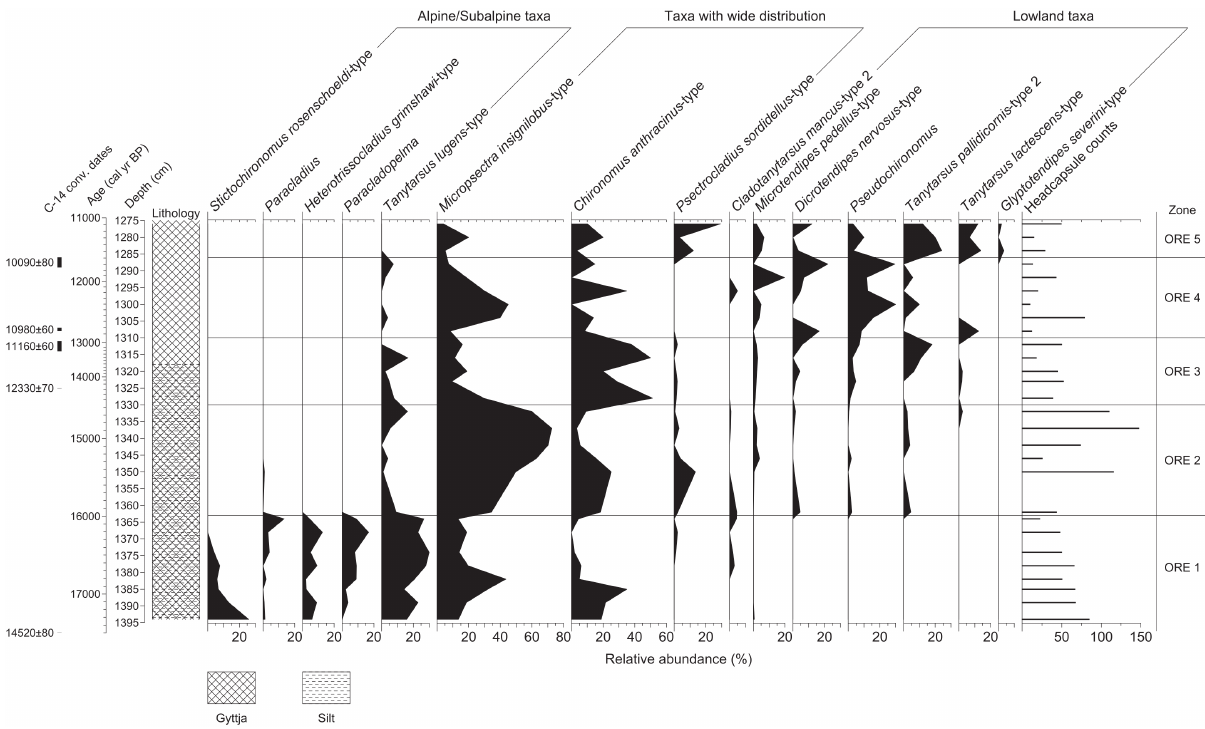
Fig. 3. The Origlio chironomid record. Relative abundances (%) of selected chironomid taxa and significant chironomid assemblage zones are shown. The chironomids are grouped according to their altitudinal preference in the Swiss Alps (Heiri et al., 2003; Heiri and Lotter, 2010) to support interpretation and highlight